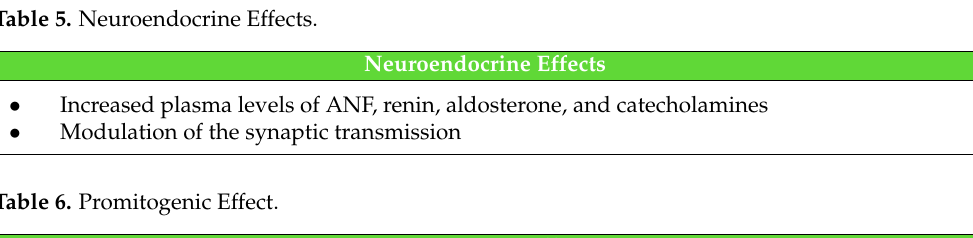
Table 6. Promitogenic